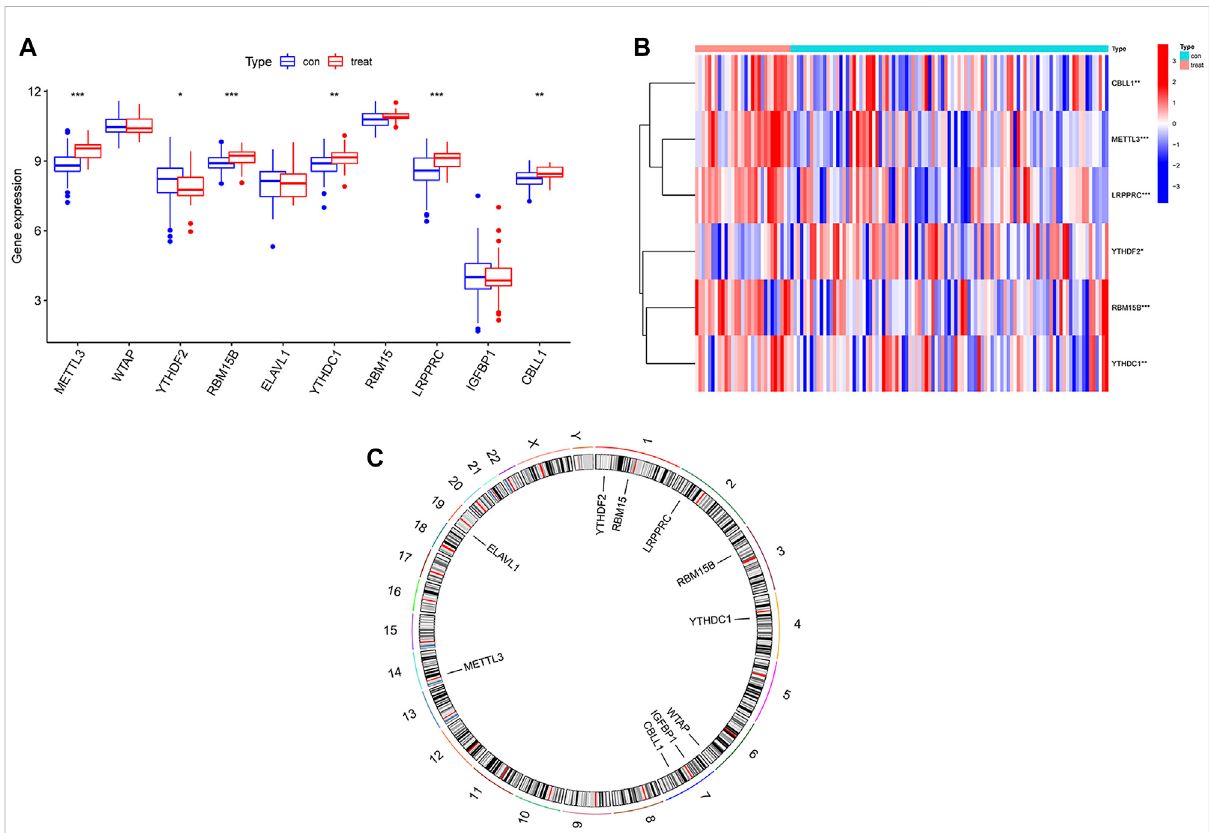
FIGURE 1 Expression of m6A regulators in osteomyelitis samples and healthy samples. (A) Expression of all 10 m6A regulators in osteomyelitis samples andnormalsamples. (B) Heatmapof6signi fi cantm6Aregulatorsbetweenthetwogroups. (C) Chromosomalcharacteristicsofall10m6Aregulators.